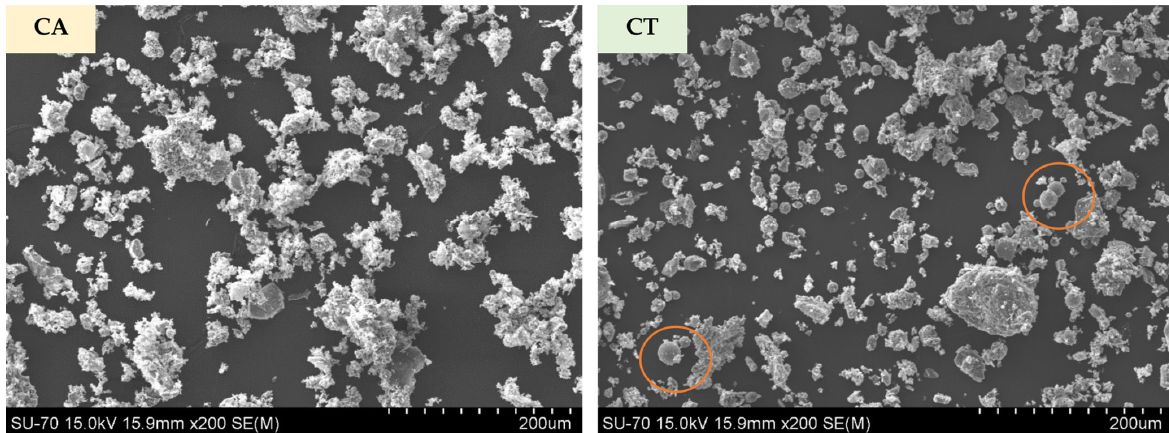
Figure 4. Micrographs of CA and CT biomass fly ashes.